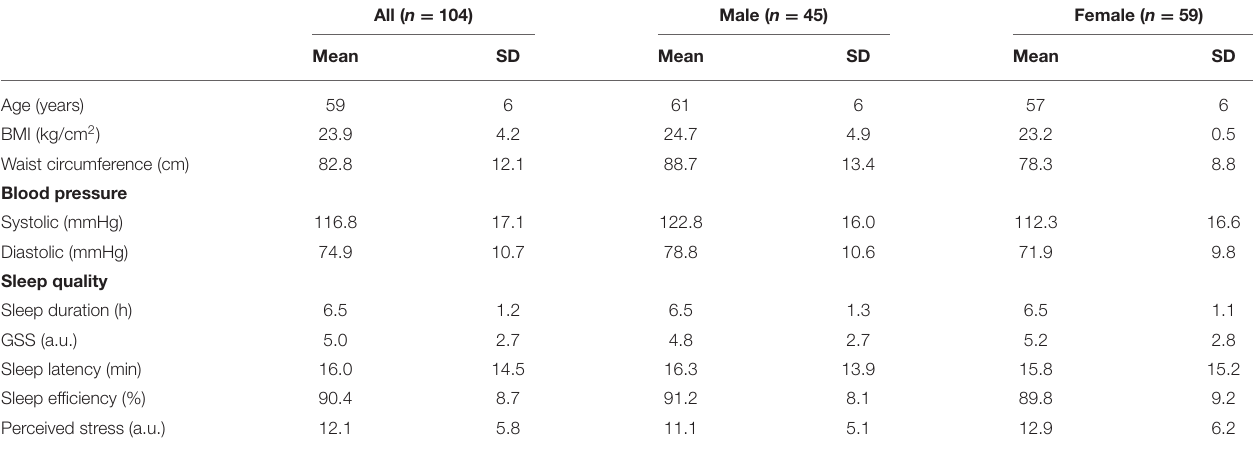
TABLE 1 | Baseline